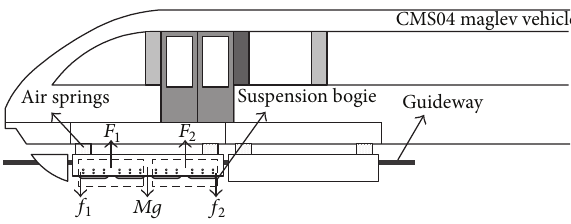
Figure 1: CMS04 mid-low-speed maglev vehicle.